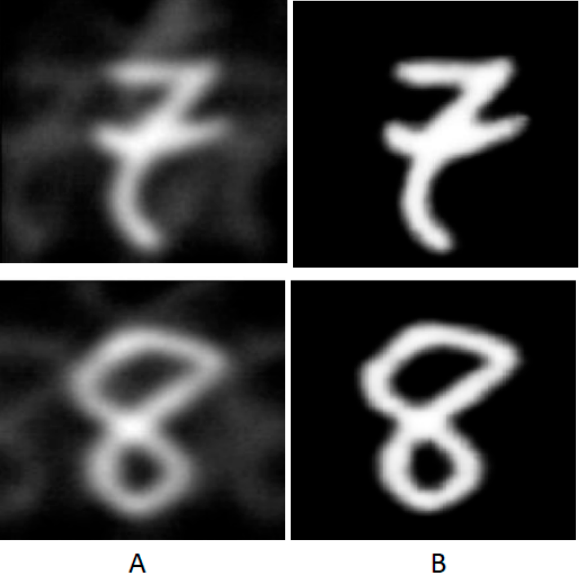
Figure 5. ( A ) Low SNR image after inverse filtering; ( B ) high SNR image after applying the proposed DL method. The SNR improvement can clearly be seen.